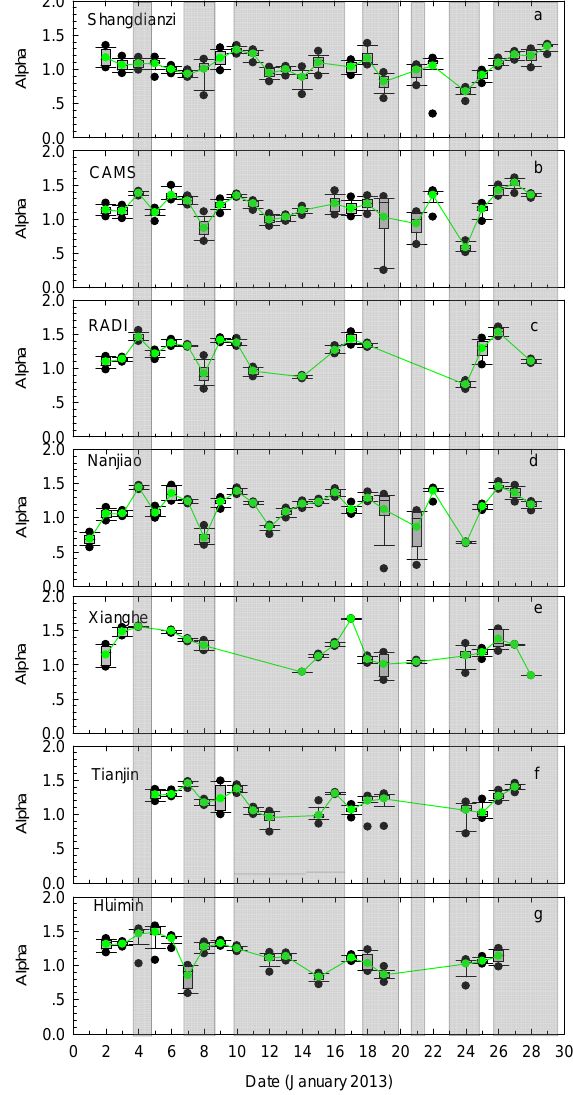
Fig. 3. Daily averaged AOD (green) and the 5th and 95th percentile box plots for the month of January 2013 at seven sites in North China Plain. Fig. 4. Daily averaged Alpha (green) and its 5th and 95th percentile box plots for January 2013 at seven sites in North China